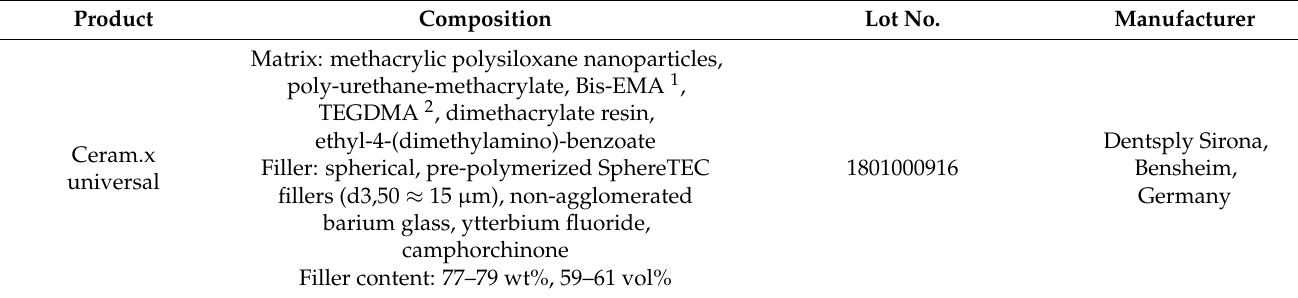
Table 1. Composition and manufacturer details of the composite material used in the present study. Product Composition Lot No.